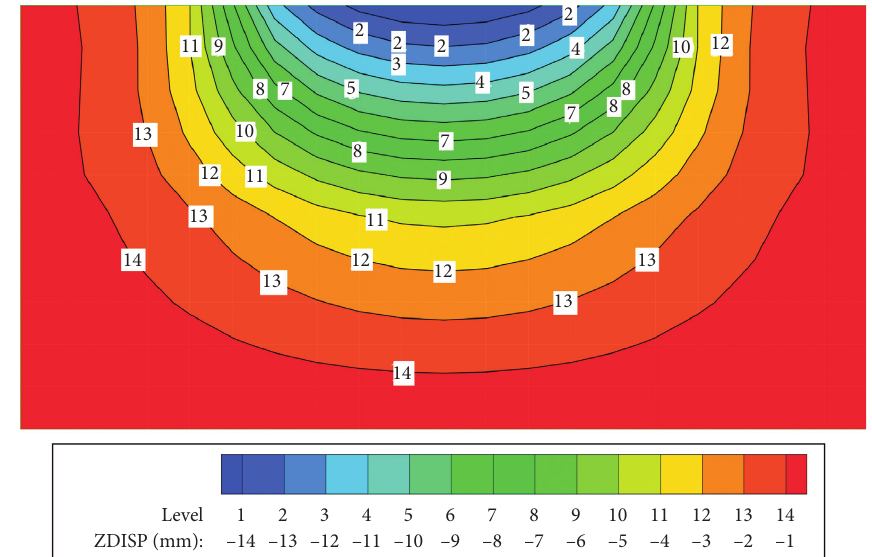
Figure 6: Calculation result of the force-water equivalent method.